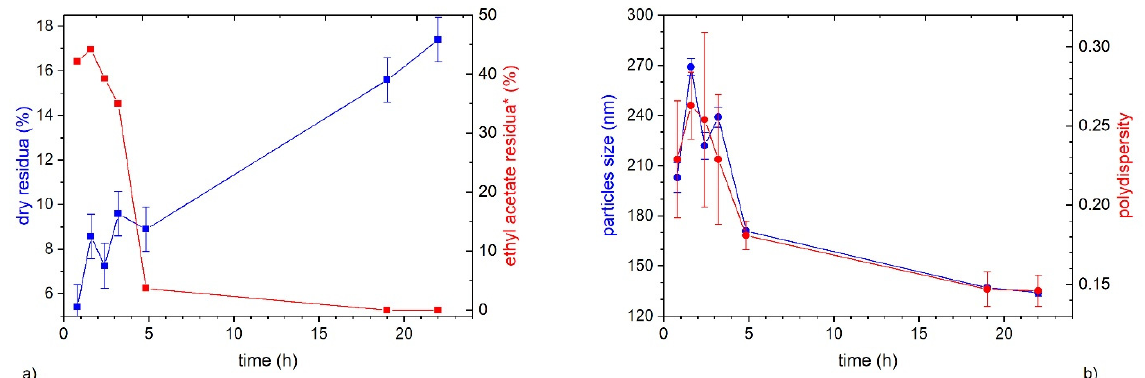
Figure 2. ( a ) Kinetics of ethyl acetate residue (red line) and dry residue (blue line) evolution; ( b ) kinetics of particles size (blue line) and polydispersity (red line) evolution over time. Data are related to test 3 in Table 1. * The highest data of ethyl acetate residua expressed in ppm are only indicative.